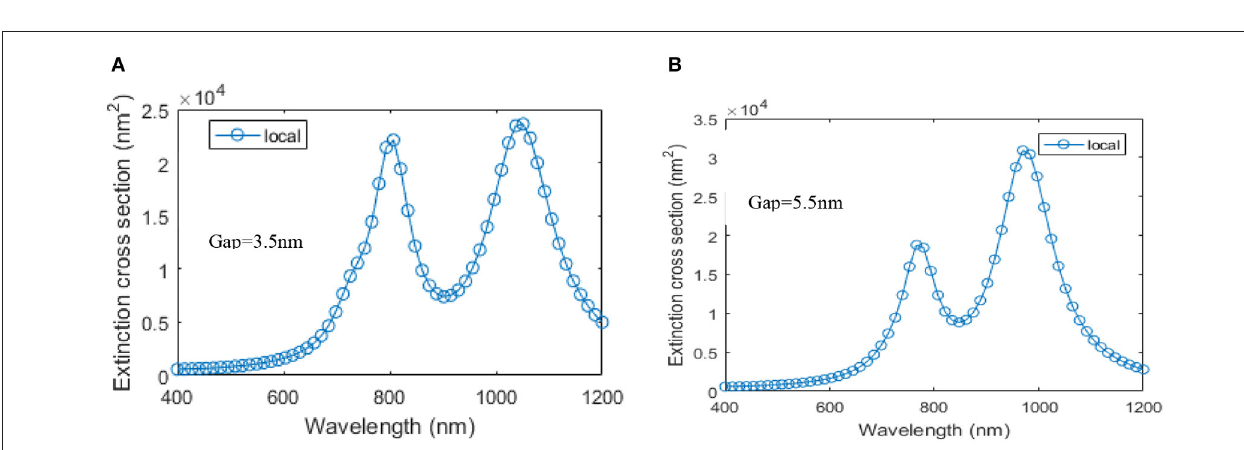
FIGURE 3 | Extinction cross-section of 25-nm-radius coupled gold nanospheres separated by gaps of (A) 3.5nm and (B) 5.5nm surrounded by